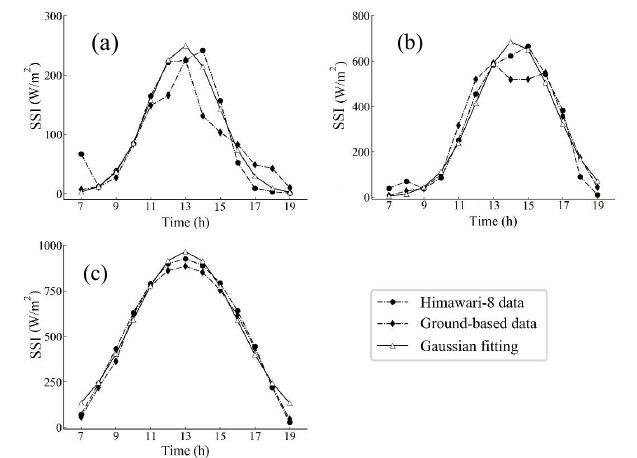
Figure 11 . Variation curves of the proposed Gaussian fitting method, the ground-based measurements from Heihe remote sensing stations, and the Himawari-8 hourly SSI products under different weather conditions in 2016: (a) moderately rainy day on August 24; (b) cloudy conditions on August 29; and (c) clear-sky conditions on August